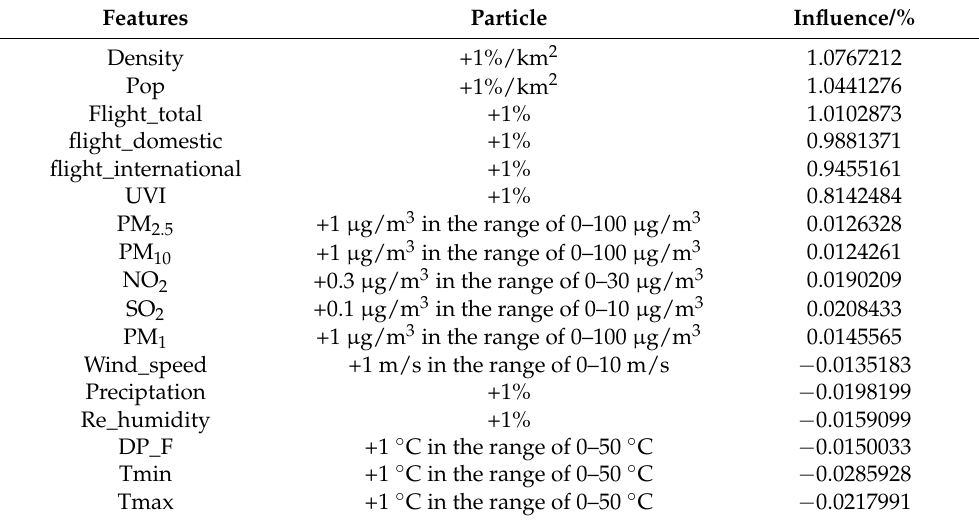
Table 6. Quantitative relationship between characteristic factors and daily number of new cases.